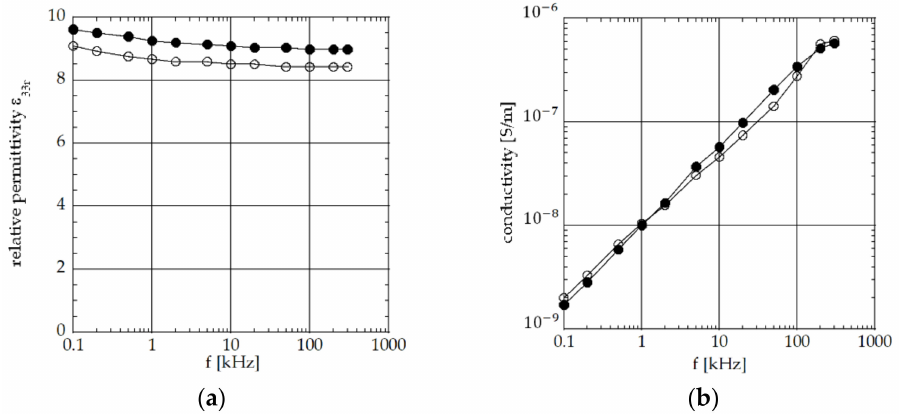
Figure 3. AlN thick films made at nitrogen concentrations of 0.4 (open circles) and 0.8 (full circles): ( a ) relative permittivity ε 33r versus frequency; ( b ) conductivity σ versus frequency. In Figure 3b, the obtained conductivity σ versus frequency is